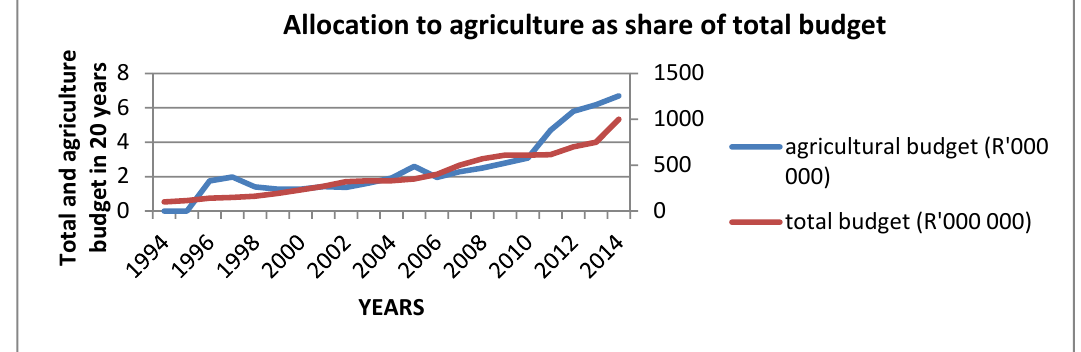
Fig. 1. Agricultural budget as of 1994 to 2014 in South Africa